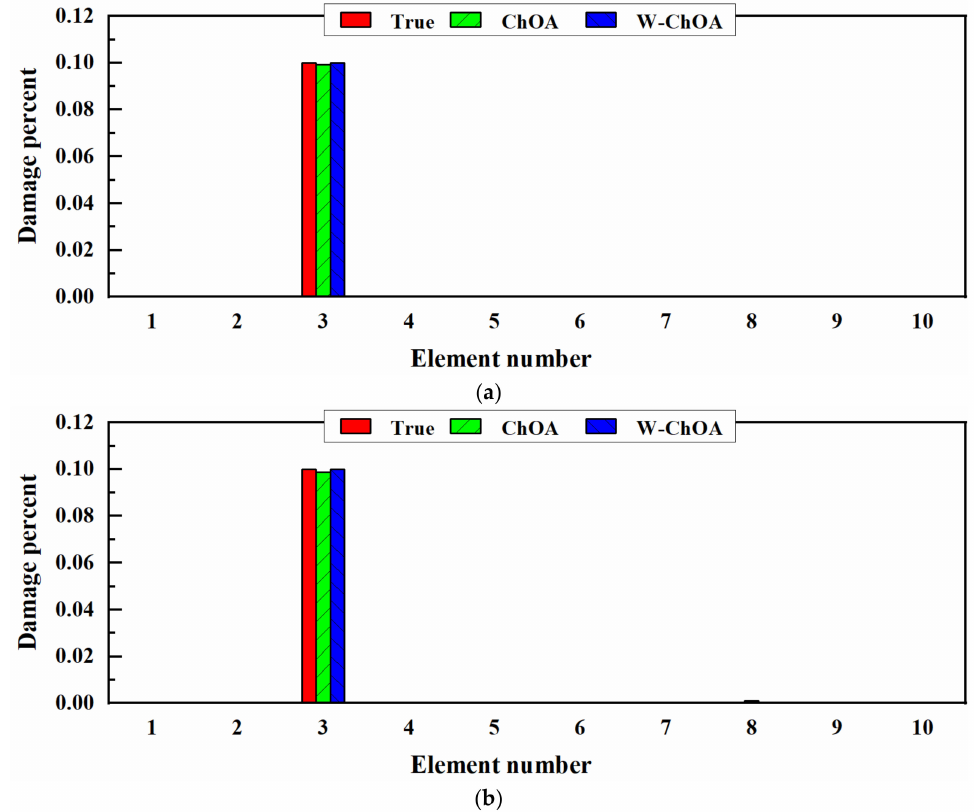
Figure 9. Single damage detection results of the simply supported beam by two chimp-based optimization algorithms. ( a ) 5% noise level. ( b ) 10% noise level.